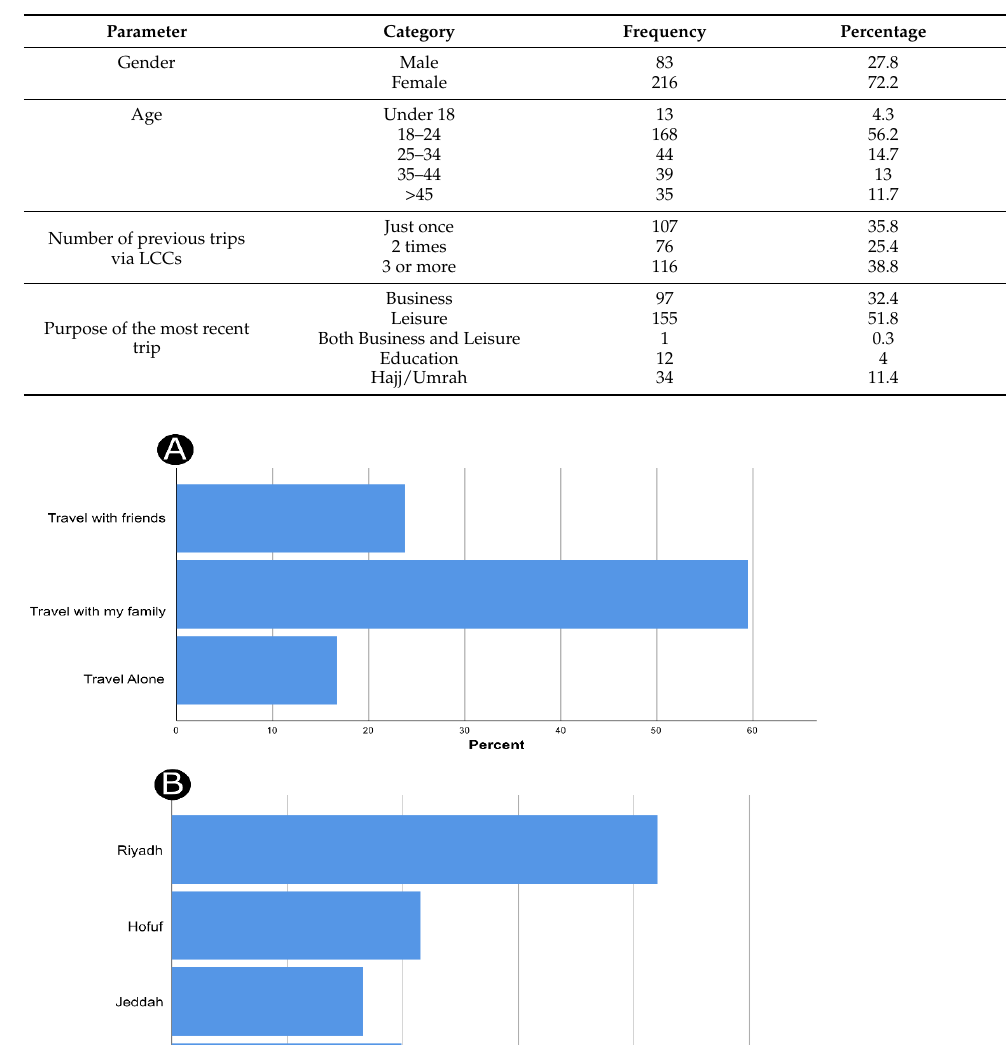
Table 1. Demographic and travel-related characteristics ( n = 299).